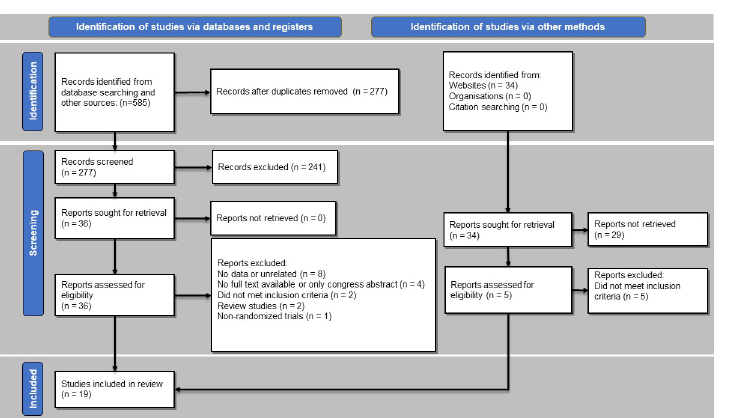
Fig 1. PRISMA flowchart of the literature search and selection of the